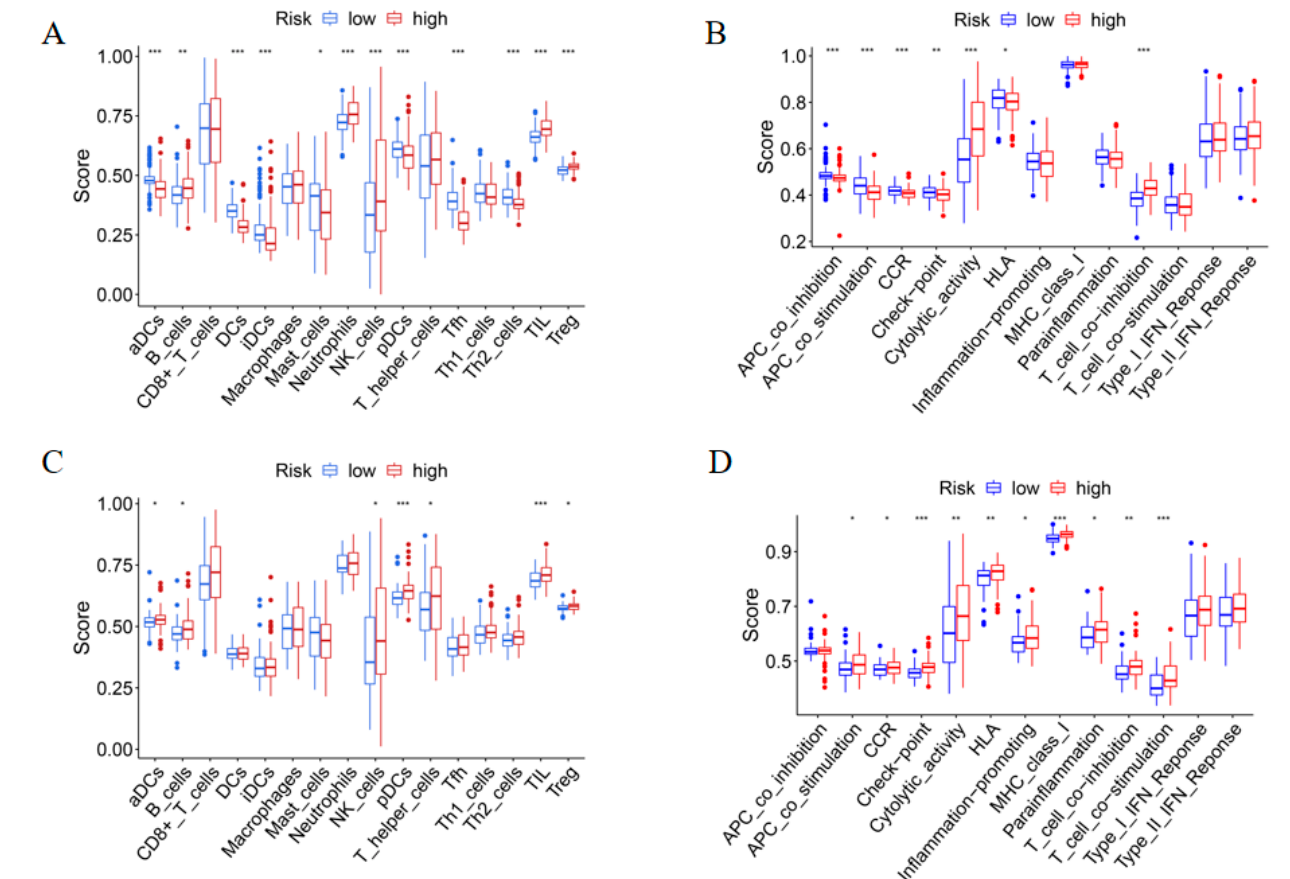
Figure 7. Comparison of the ssGSEA scores of immune cells and immune pathways for two subgroups in both the TCGA-TARGET and GEO cohorts. ( A , B ) Enrichment scores of 16 types of immune cells ( A ) and 13 immune-related pathways ( B ) between low- (green box) and high-risk (red box) group in the TCGA cohort. ( C , D ) Enrichment scores of 16 types of immune cells ( C ) and 13 immune-related pathways ( D ) between low- (green box) and high-risk (red box) group in the GEO cohort. * p < 0.05; ** p < 0.01; *** p < 0.001.